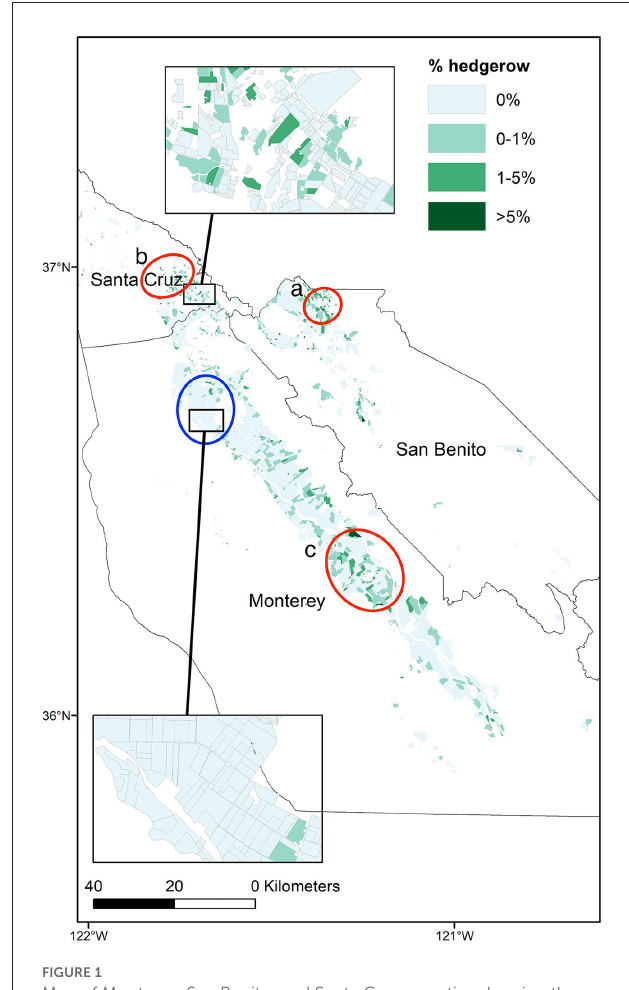
FIGURE1 Map of Monterey, San Benito, and Santa Cruz counties showing the percent area of each ranch covered by hedgerows. Inset maps show areas of higher (Santa Cruz) and lower (Monterey) hedgerow adoption. Red ovals indicate significant hotspots of hedgerow adoption, while blue ovals indicate